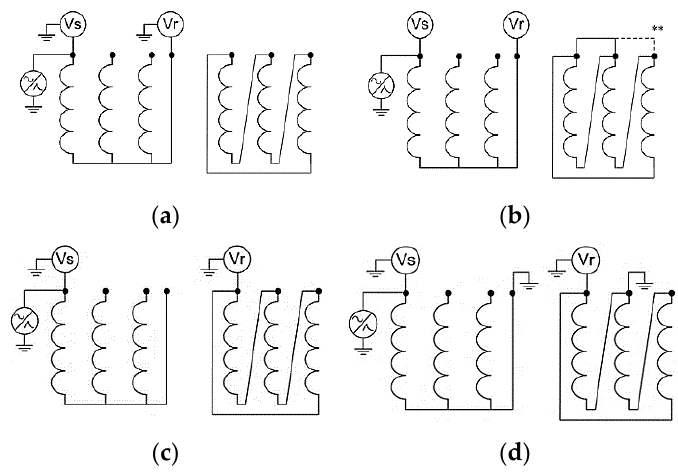
Figure 2. Connection schemes for FRA measurements; ( a ) end-to-end open circuit (OC), ( b ) end-to-end short circuit (SC), ( c ) capacitive inter-winding (CIW), ( d ) inductive inter-winding (IIW) [9].